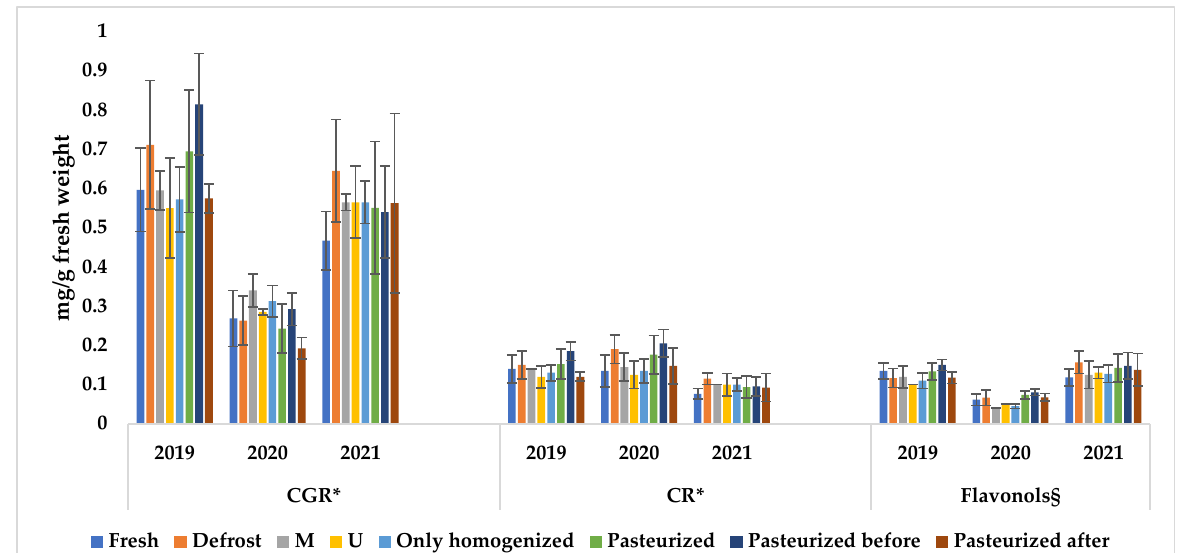
Figure 3. Average anthocyanins and flavonols content in the three vintages and in the different clusters. * Expressed as cyanidin-3-rutinoside equivalents; § expressed as rutin equivalents.